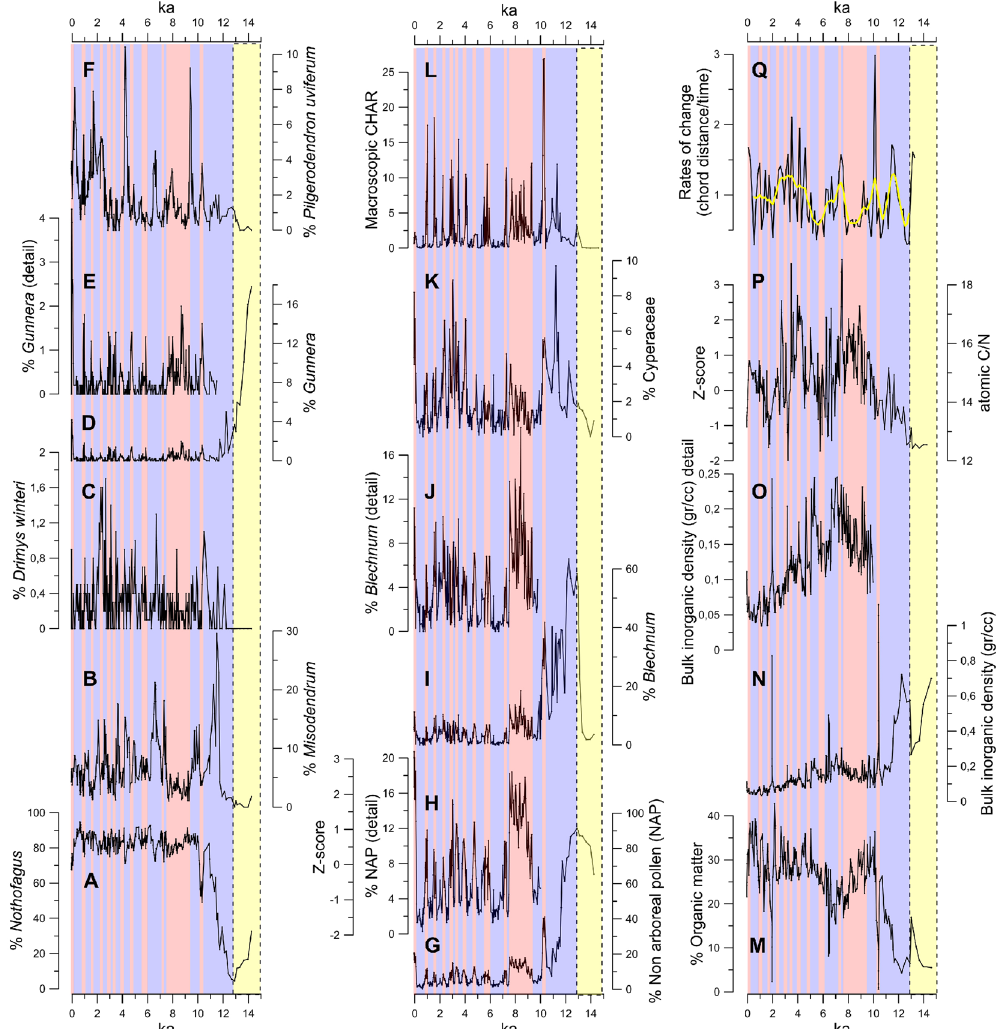
Figure 2. The Lago Cipreses record. The left column indicates percentage variations in arboreal taxa: A = Nothofagus dombeyi type; B = Misodendrum , a hemiparasite of Nothofagus . The presence of this mistletoe attests or the local presence of its host. C = Drimys winteri , a relatively hygrophilous tree characteristic of the humid forests of southwestern Patagonia; D = the herb Gunnera (possibly G. magellanica ) and a detailed inset plot (E) to show its Holocene variations; F = Pilgerodendron uviferum , a cold-resistant hygrophilous conifer typically found in hyperhumid habitats of Patagonia. The central column shows the sum of terrestrial Non Arboreal Pollen (NAP) in G, and a detailed view (H) of its Holocene variations; the fern Blechnum (possibly B. penna-marina ) in I, and a detailed view (J) of its lower-magnitude Holocene changes; the macrophyte Cyperaceae is shown in K, along with the macroscopic charcoal accumulation rates (CHAR) in L. The right column shows the percent organic matter of the sediments (M), along with the bulk inorganic density (N), and a detail to allow visualization of relatively low-magnitude variations during the Holocene (O). The bulk sedimentary organic matter C/N ratio (P) is expressed in its original units and standardized units in the z-scored secondary scale. The black curve in Q shows the rates-of-change parameter along with a weighted running mean in yellow. The red vertical rectangles indicate dry/warm phases which alternate with cold/humid phases depicted as blue vertical rectangles. The yellow vertical rectangles with dashed black lines denote an extreme cold/wet interval correlative of the Antarctic Cold